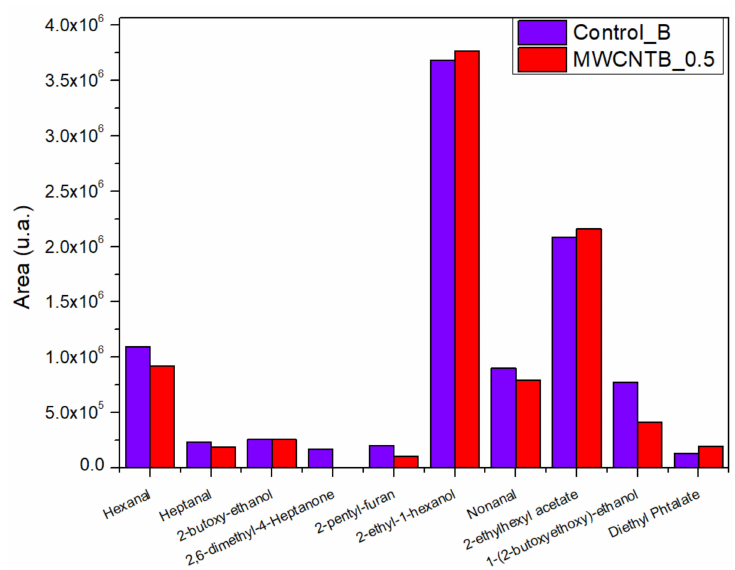
Figure 7. VOC released by bovine treated leathers compared with the control sample.